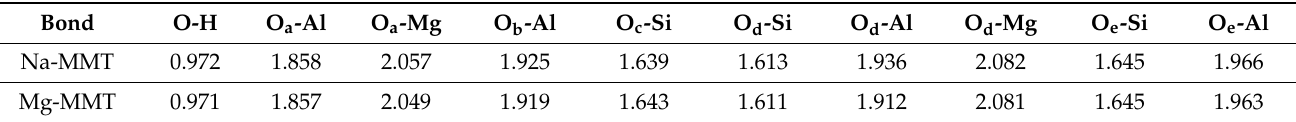
Table 2. The bond lengths (Å) in optimized structure of the Na-MMT and Mg-MMT at ideal condition. Bond